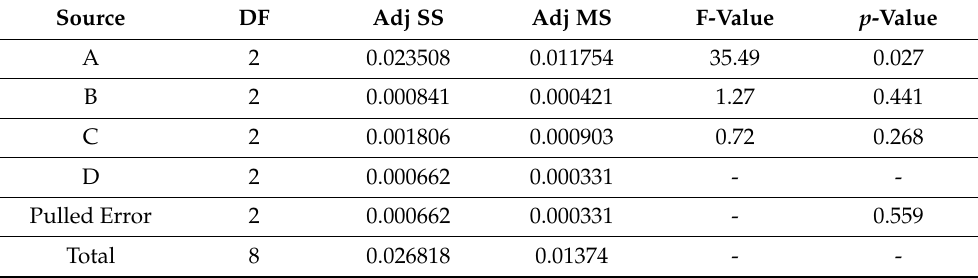
Table 6. Response of variable parameters of cylindricity.